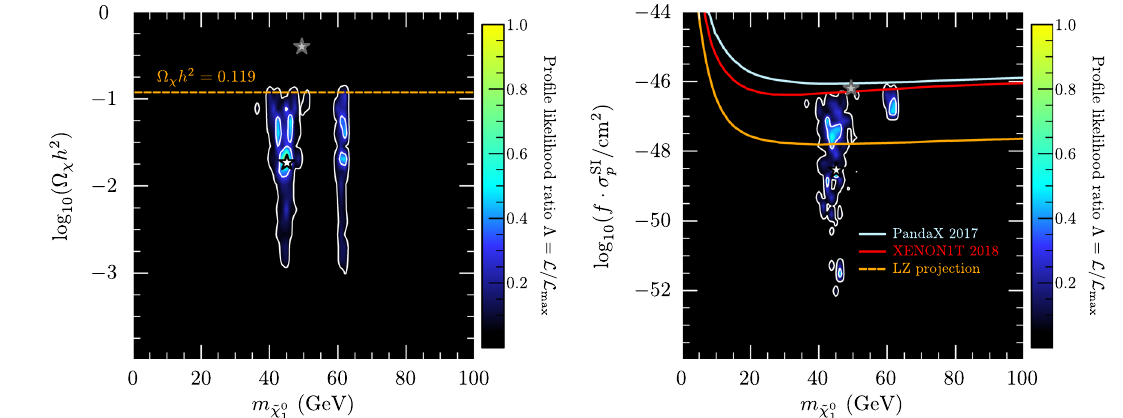
Fig. 17 Combined collider and DM profile likelihood of the relic den- sity of DM (left) and spin-independent direct detection cross-section (right), both plotted against the DM candidate mass. The contours show the 1 σ and 2 σ regions. The white star marks the point with the high-